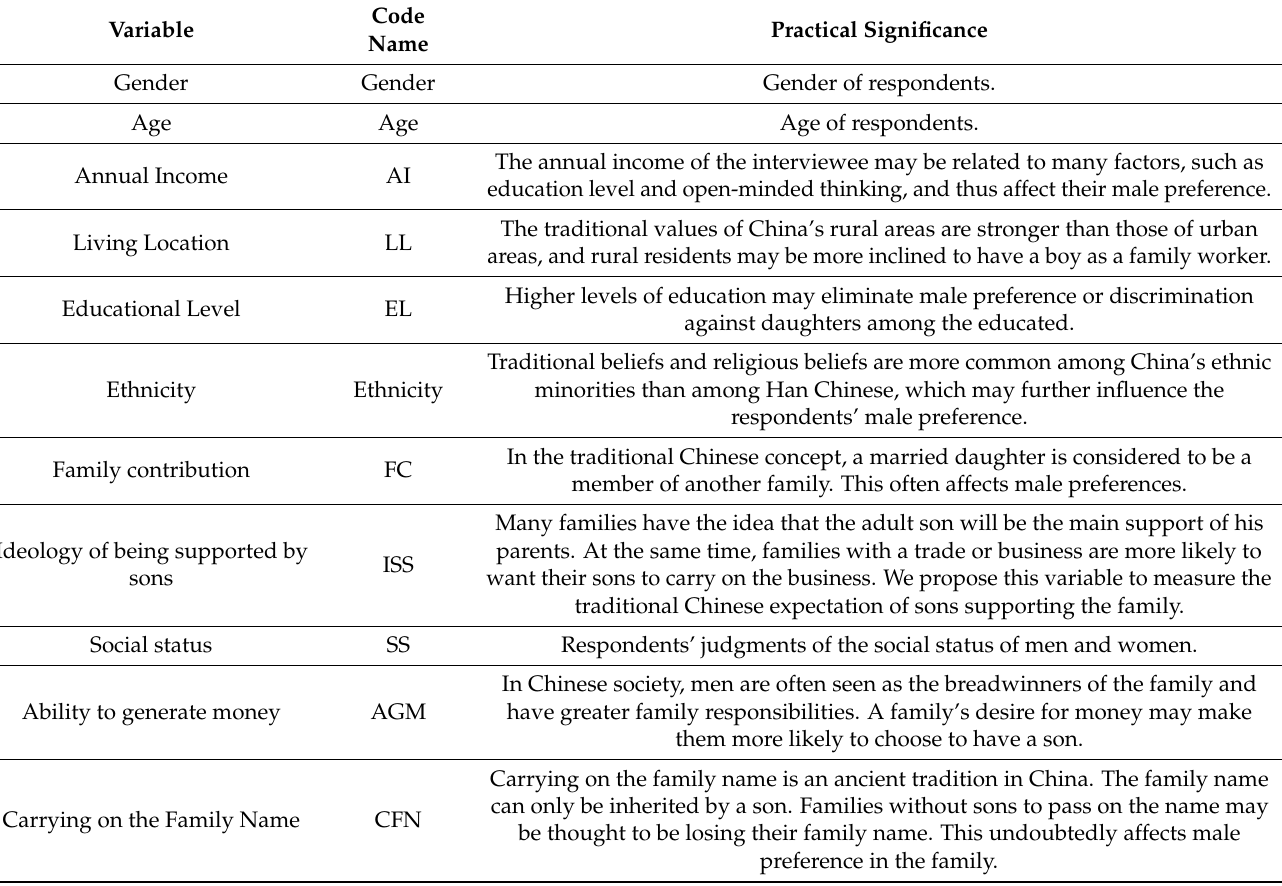
Table 1. The list of variables in the